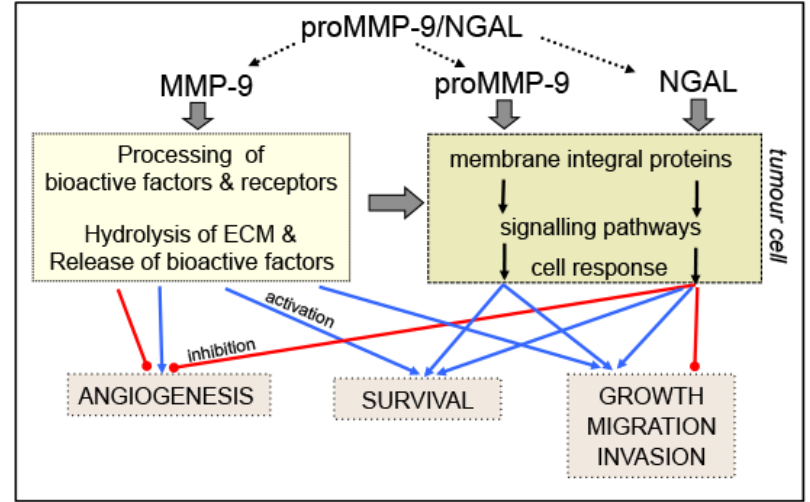
Figure 2. Schematic diagram of the roles of (pro)MMP-9, NGAL and pro-MMP-9/NGAL in cancer. Active MMP-9 degrades structural components within the ECM, facilitating tumor cell invasion and metastasis and thus releasing bioactive factors (growth factors, cytokines and angiogenic factors) embedded in the ECM . MMP-9 also generates angiogenesis inhibitors, such as endostatin and tumstatin. MMP-9 processes and activates or inactivates signalling molecules (cytokines, chemokines, growth factors, receptors) that target tumor cells (cell growth, survival, migration, invasion and metastasis) and surrounding endothelial cells (tumour-associated angiogenesis). NGAL (whether bound to siderophore/iron or not) and pro-MMP-9 bind to integral membrane proteins on tumour cells leading to pro- ( ) or anti- ( ) tumour effects on growth, survival, migration, invasion and angiogenesis. The possible actions of the pro-MMP-9/NGAL complex on cell events remain to be identified ( .....